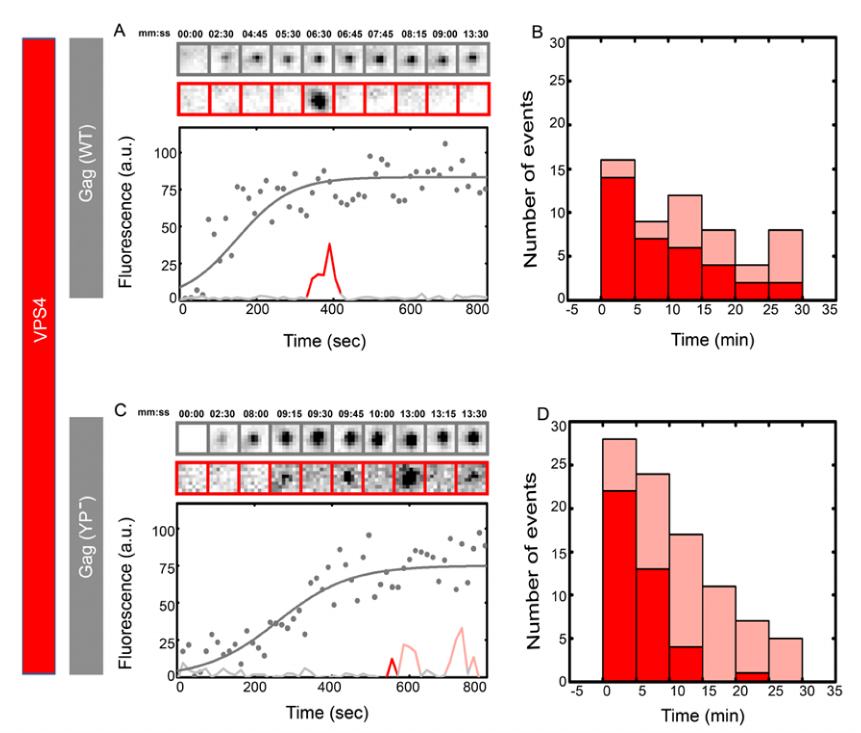
Figure 3. Single versus multiple transient recruitments of VPS4 into HIV Gag VLPs versus HIV Gag (YP-) VLPs.HeLa cells were transfected with 1200 ng of ∆ CMV-VPS4-h37-mcherry and 300 ng (total 1500 ng of plasmids) of Gag–mCherry ( A , B ) or Gag (YP-)–mCherry ( C , D ) and imaged 7 h after transfection. Assemblies of individual representative VLPs are shown with intensity plots (as gray dots and fitted with gray line) and cropped TIRF images of the Gag (top, gray) and VPS4 (bottom, red) for ( A ) Gag–mCherry VLPs and ( C ) Gag (YP-)–mCherry VLPs. Histograms of the first time (dark red) and later recruitments (light red) of VPS4 are shown for ( B ) Gag-mChery VLPs and ( C ) Gag (YP-)–mCherry VLPs. The majority of the first VPS4 recruitment was within 1–10 min after the VLP assembly completed during both YP- and WT